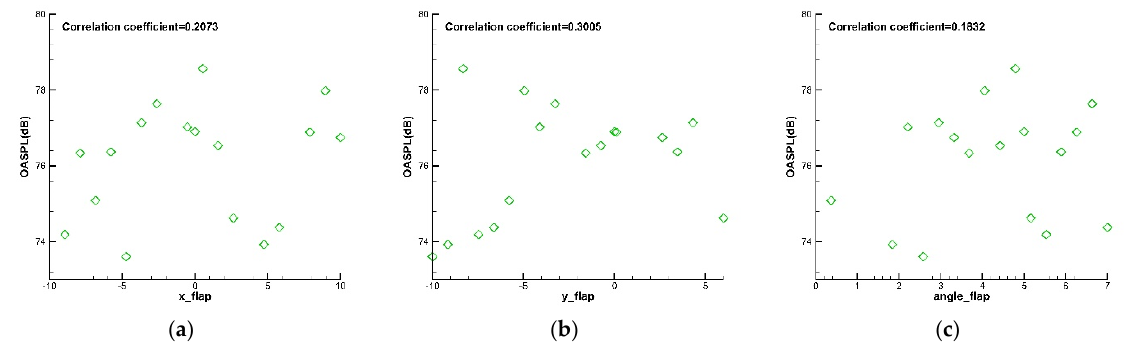
Figure 15. Scatter plots of OASPL versus x_flap ( a ); Scatter plots of OASPL versus y_flap ( b ) Scatter plots of OASPL versus angle_flap ( c ).